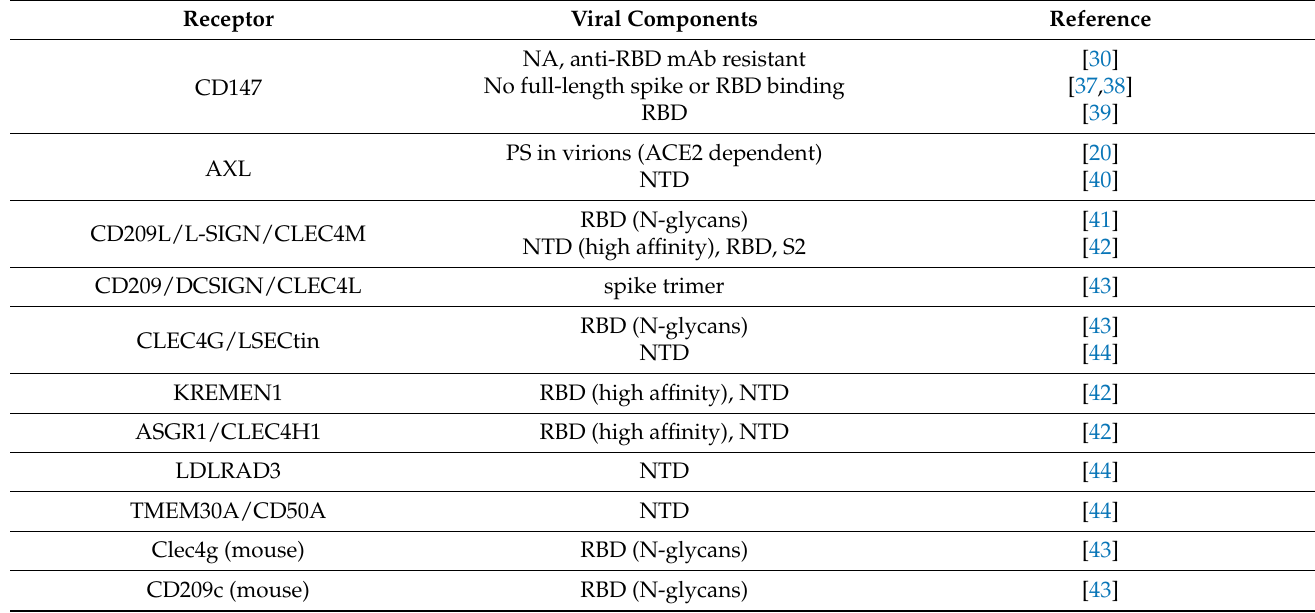
Table 1. ACE2-independent alternative receptors and viral components that interact with receptors. Receptor Viral